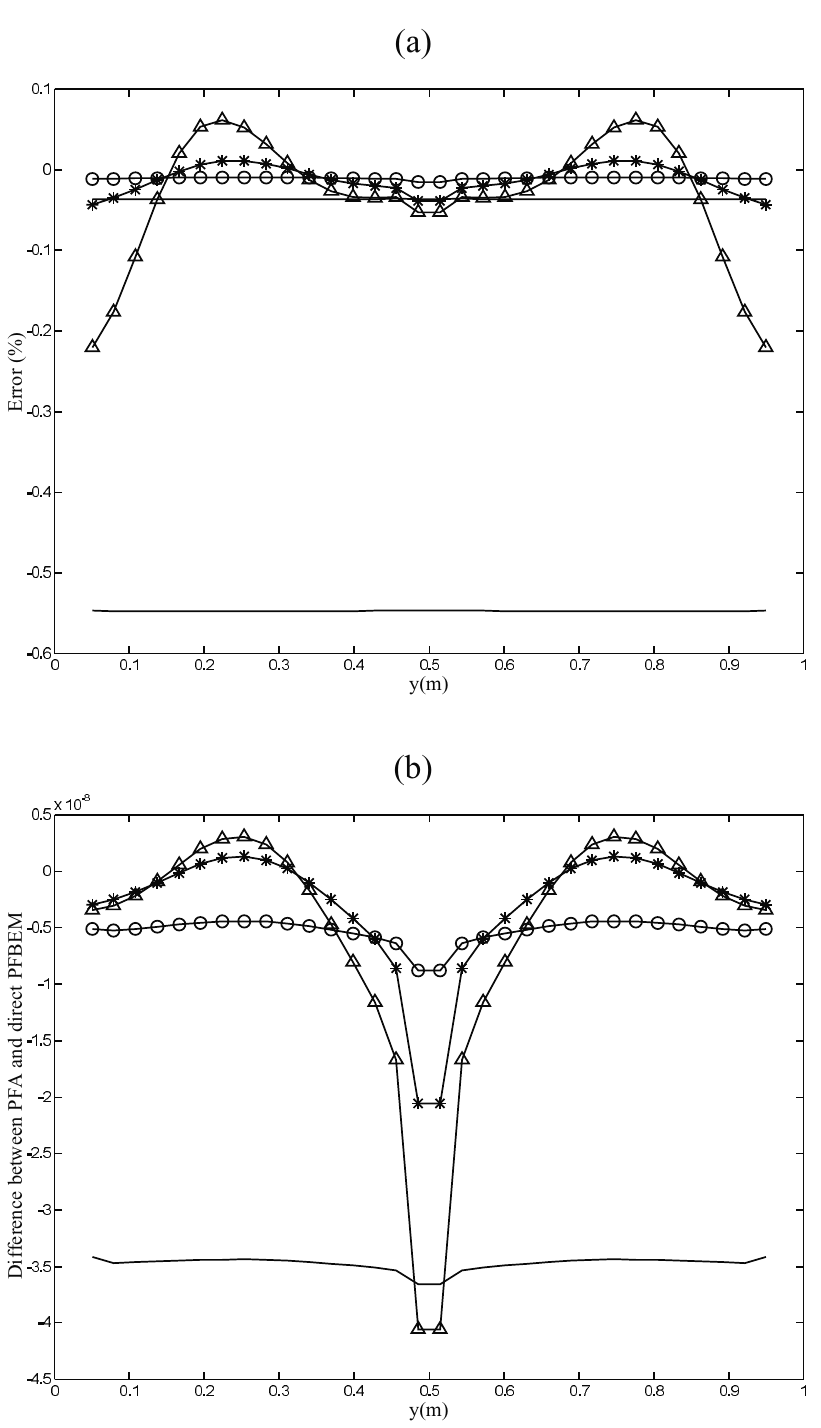
Fig. 10. Comparison of (a) error rate, (b) difference between EFA analytic solution and direct EFBEM solution along the representative line at various damping loss factors when f = 5 kHz and the number of boundary elements is 64: —, η = 0 . 001 ; - - -, η = 0 . 005 ; , η = 0 . 01 ; , η = 0 . 05 ; , η = 0 . 1